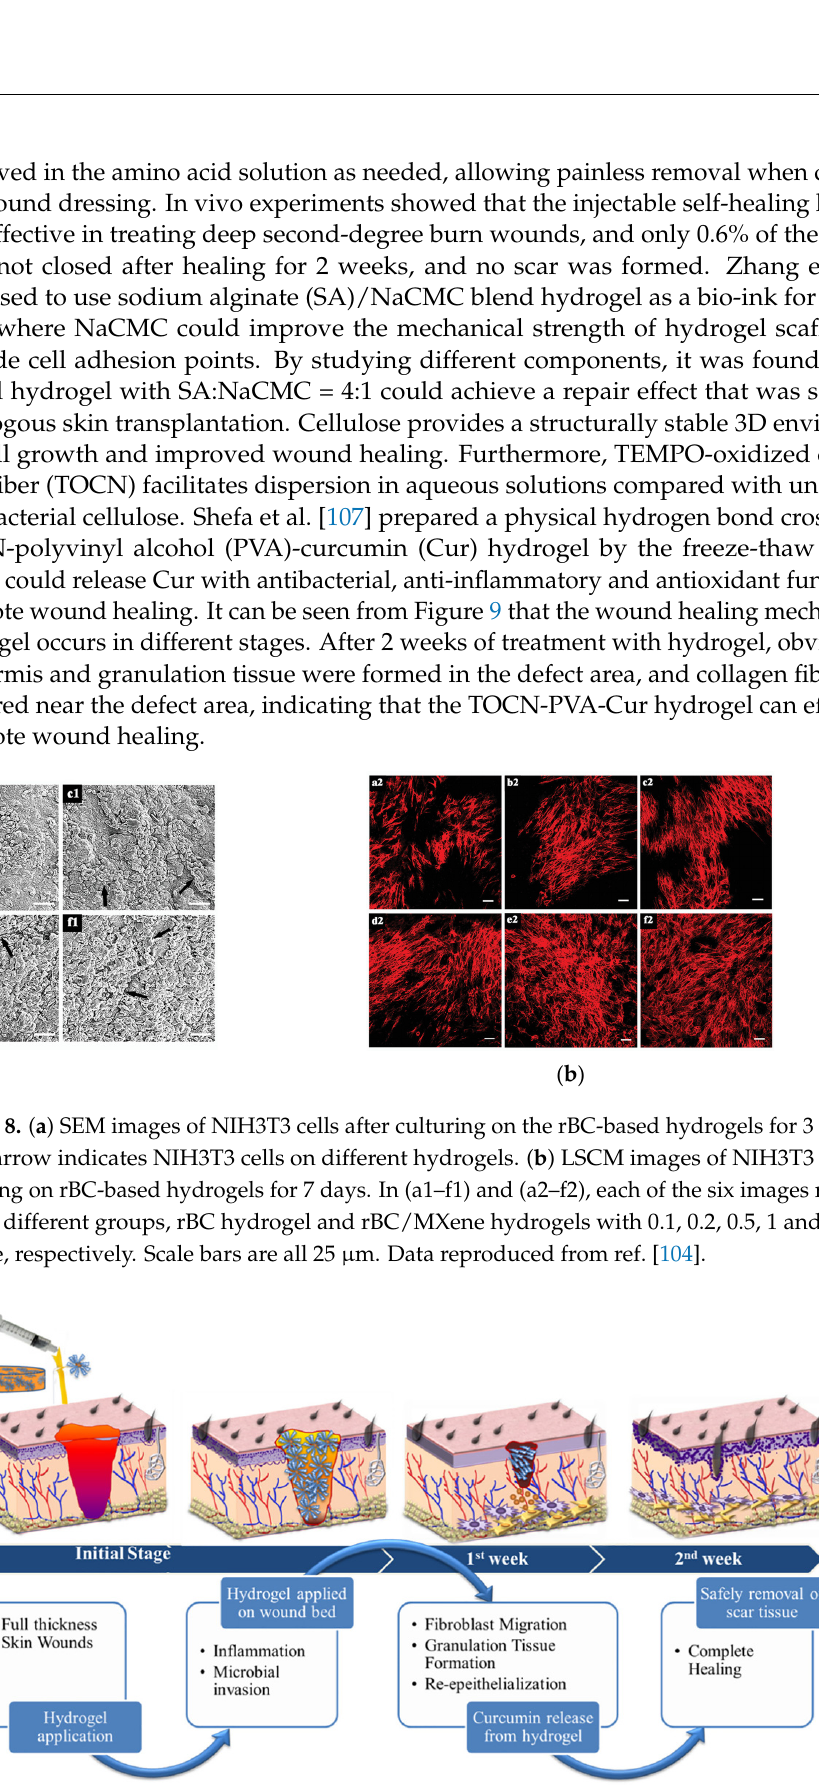
Figure 9. Wound healing mechanism at the same stage after hydrogel application. Data reproduced from ref. [107].